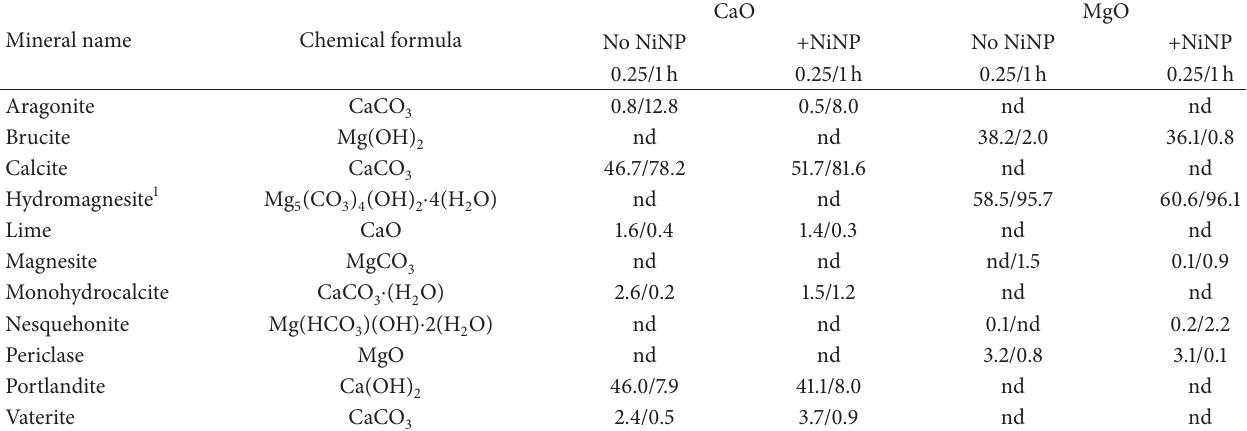
Figure 5: Carbonation conversion of AOD and CC slags after mineral carbonation, using S/L ratio of 50 g/1000 mL, determined by TGA. Table 3: Mineral composition of CaO and MgO after fifteen-minute and one-hour carbonation experiments (S/L = 50 g/L), under mechanical mixing, with/without NiNP addition, determined by QXRD (wt% of crystalline